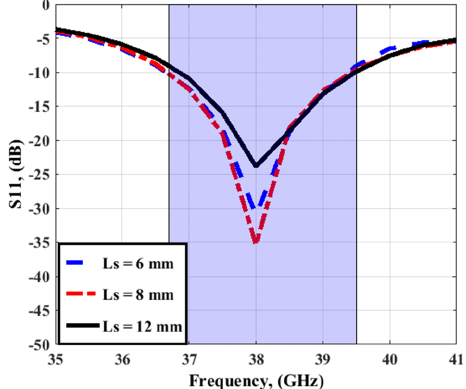
Figure 8. The effect of the Ls on the antenna performance.